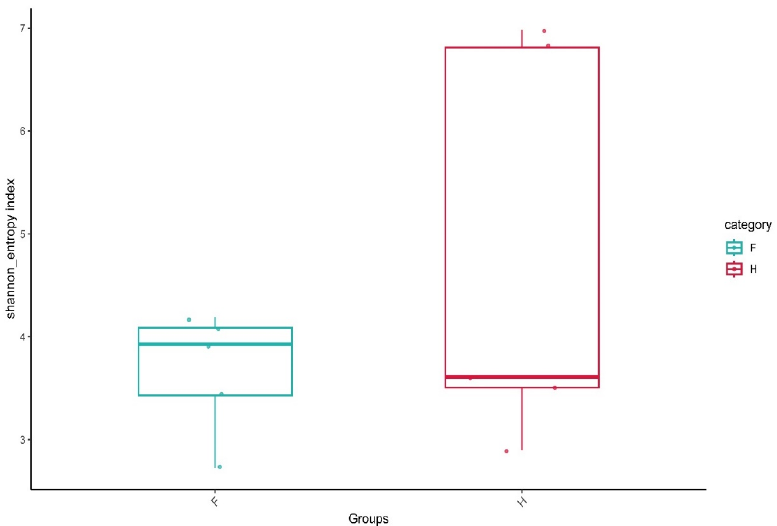
Figure 1. Boxplot of Shannon index. F means factory production; H means household handmade.